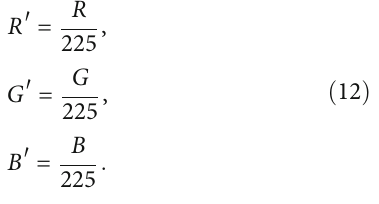
7. Color Printing Model color “ CMYK ” is the model chromatic main colors used that are di ff erent from the colors blue, green, and red, where the colors used are the color of cyan, magenta, yellow, and key color (black color) as in Figure 4, suitable for inks and so used in color printing devices [15].